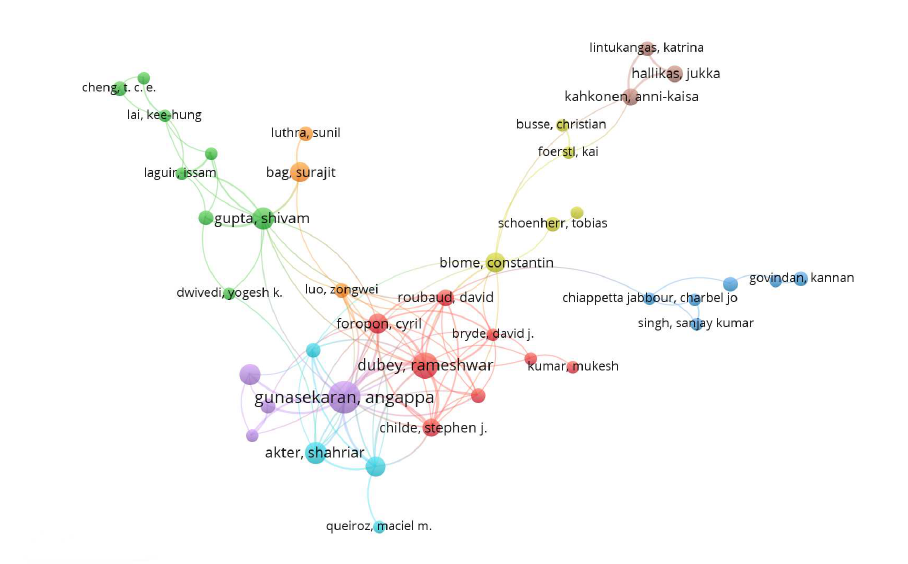
Figure 4. Cluster of authors in Web of